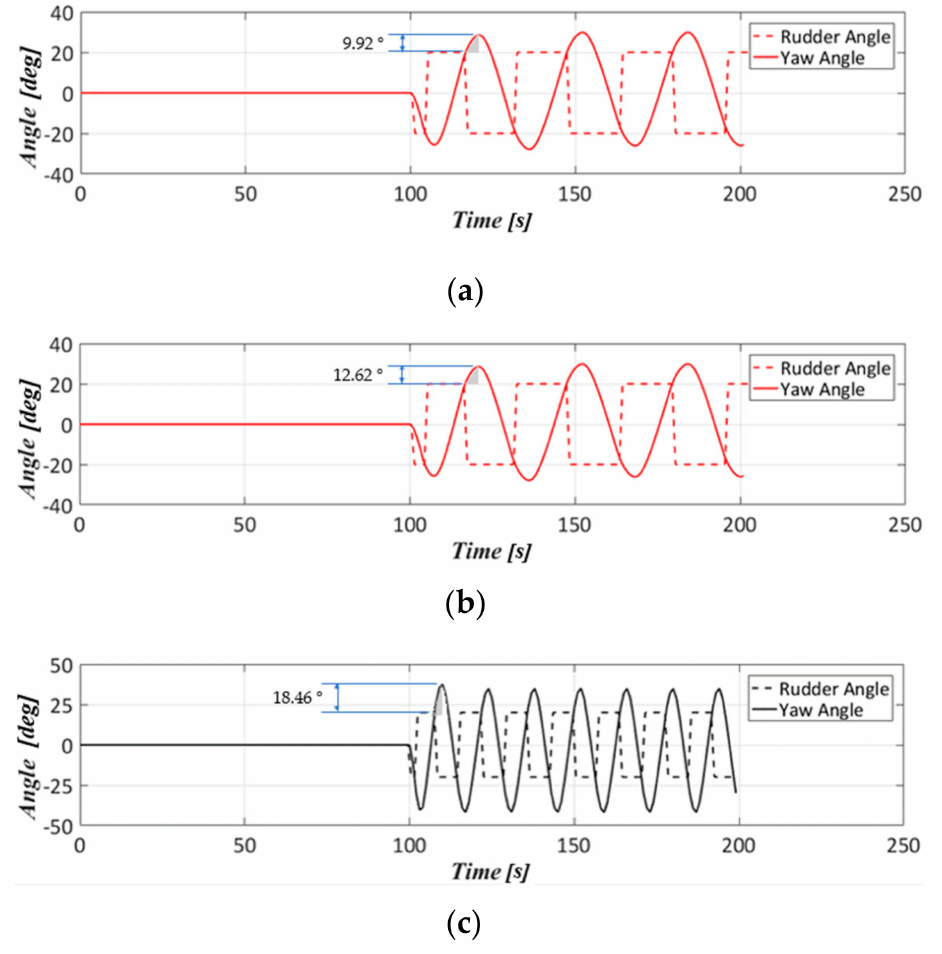
Figure 15. Time series of rudder and yaw angles at ( a ) U = 0.5 m/s, ( b ) U = 1 m/s, and ( c ) U = 1.5 m/s. The maximum overshooting angle is highlighted by the gray